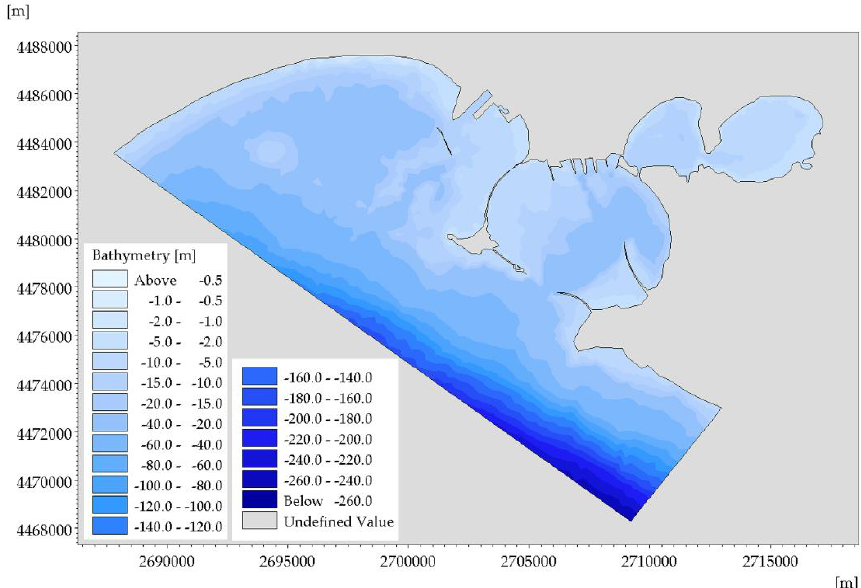
Figure 2. Bathymetry of the simulated domain and computation mesh.